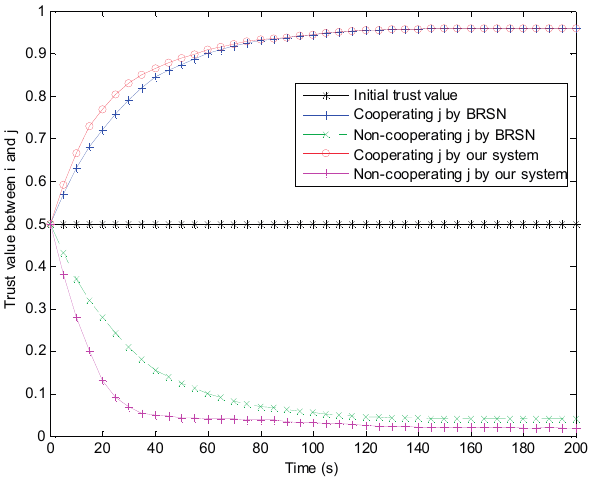
Figure 10. Evolution of j’s trust values in sensor node i.